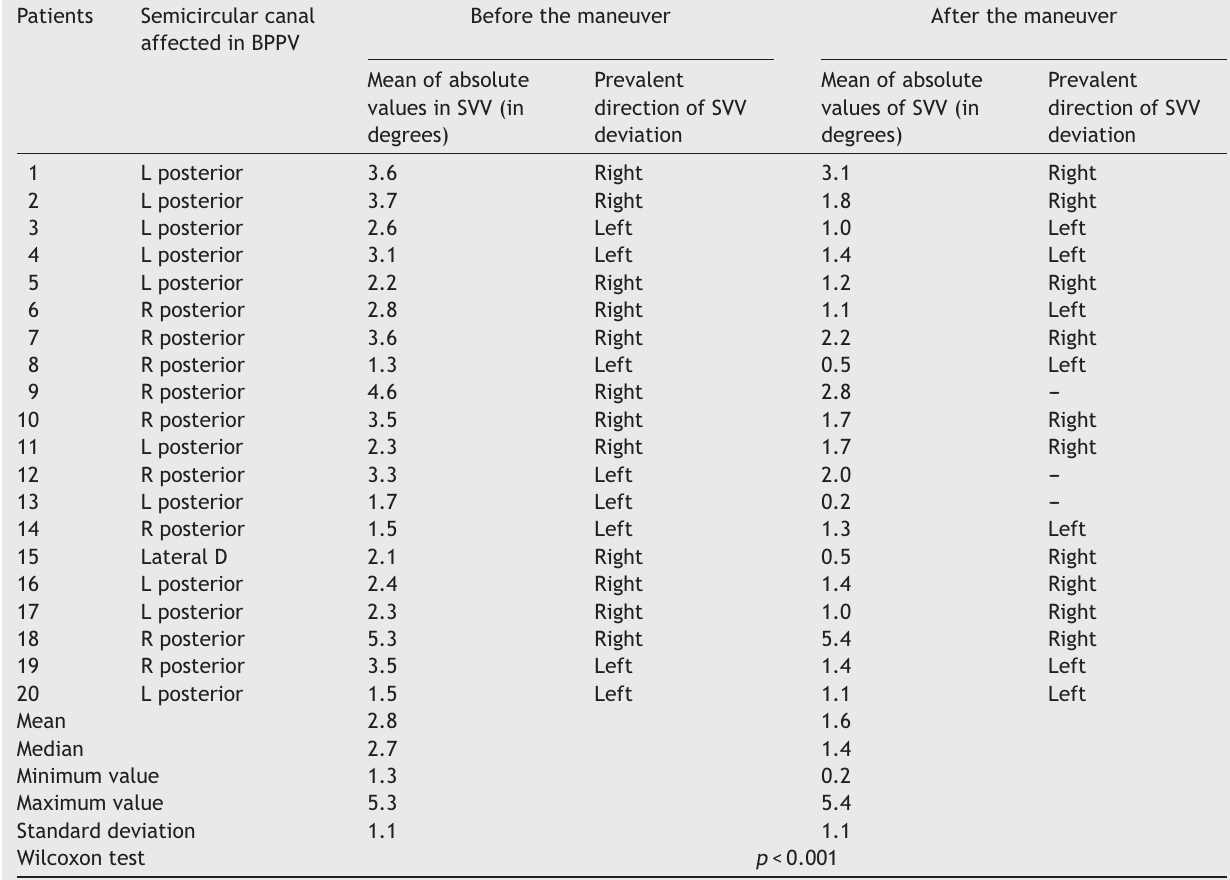
Absolute values and statistical data of vertical deviations and its direction before and after the repositioning maneuver in patients with benign paroxysmal positional vertigo.